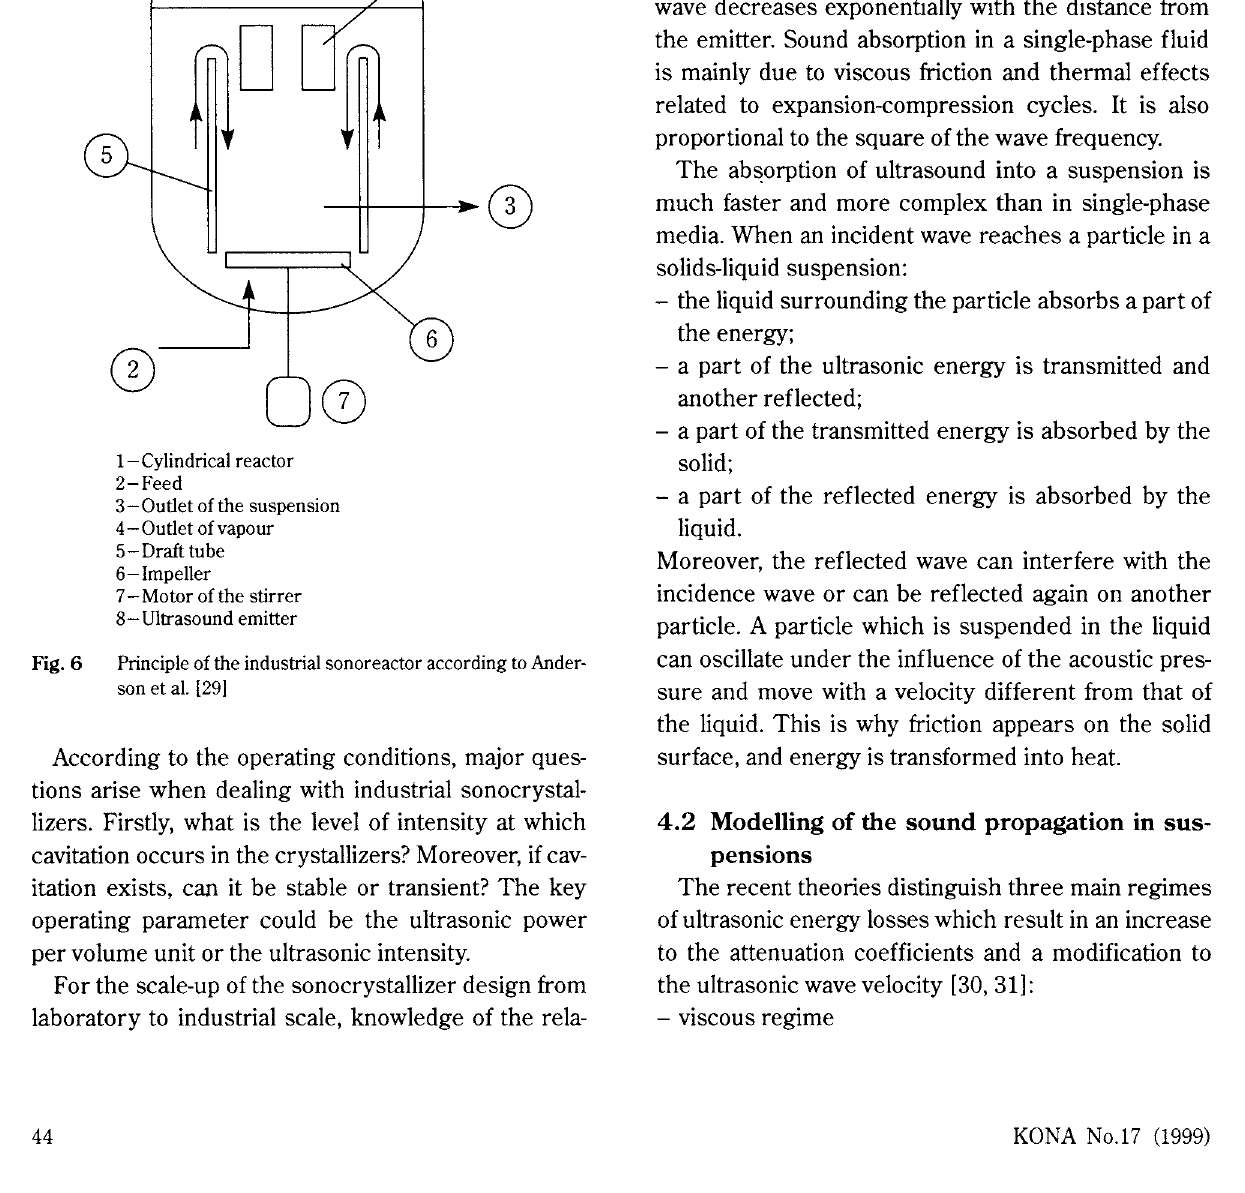
Fig. 5 Cross-sectional view of the irradiated part in the loop of the reactor